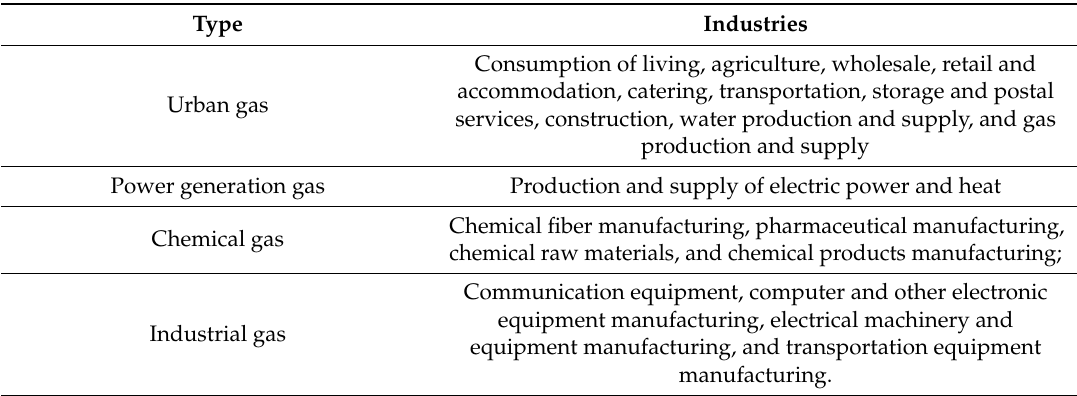
Table 1. Classification of natural gas consumption